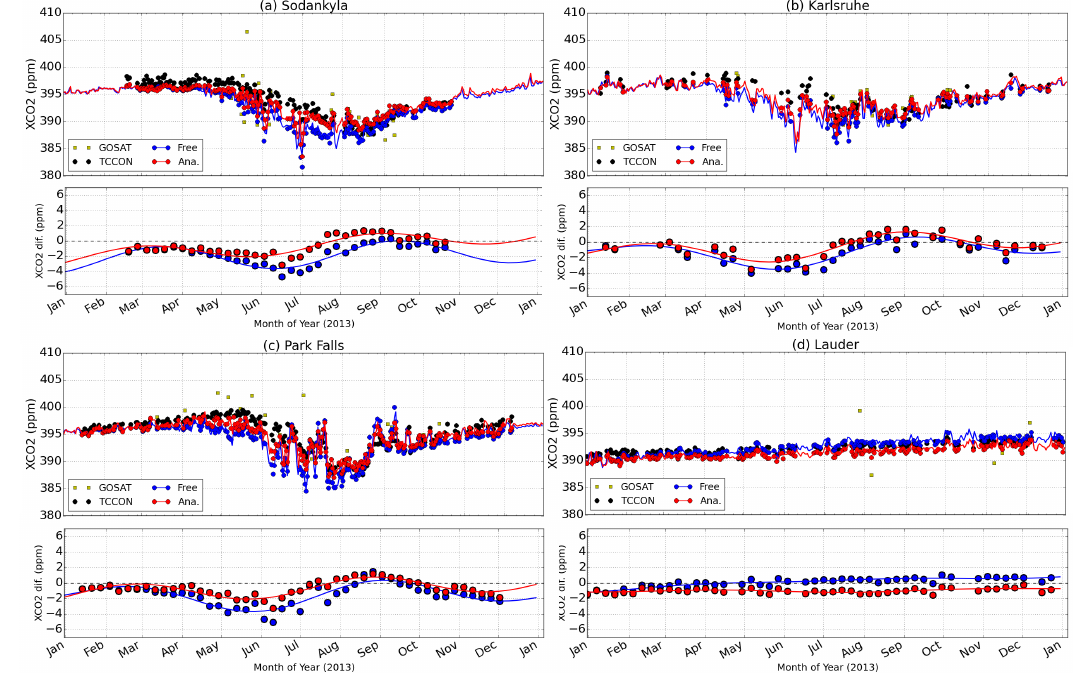
Figure 4. Time series of XCO 2 (in ppm) at (a) Sodankylä, Finland; (b) Karlsruhe, Germany; (c) Park Falls, USA; and (d) Lauder, New Zealand, between 1 January and 31 December 2013. For each station, the top panel presents the daily averaged data from TCCON (black dots), the daily averaged data from GOSAT co-located in time and space with the station (yellow squares), the simulated XCO 2 (solid lines) and the daily averaged simulated XCO 2 in the observation space (coloured dots). The bottom panel presents the weekly averaged bias of the simulated XCO 2 against the TCCON data (coloured dots) and the smoothed bias (solid lines). Blue represents the free run, while red is for the